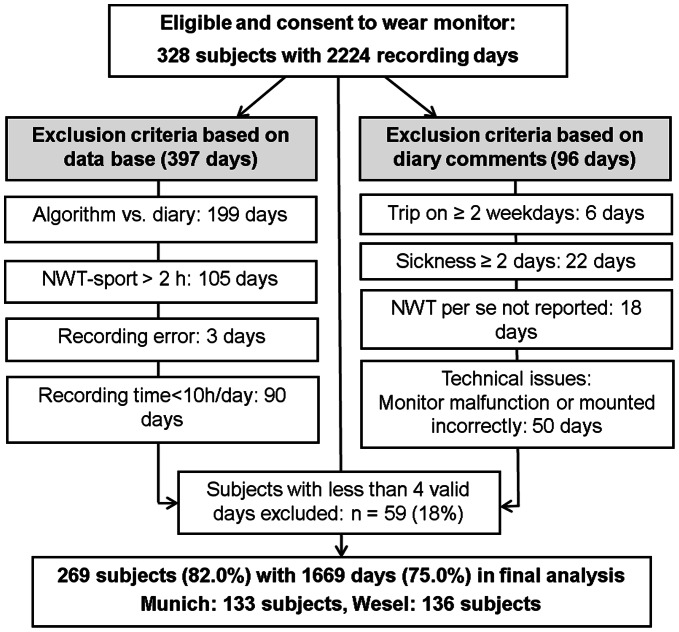
Exclusion of recorded days due to quality control in the ongoing GINIplus study.(NWT: non-wear time, NWT-sport: non-wear time during sport activities, algorithm: NHANES algorithm for detecting NWT [33]).